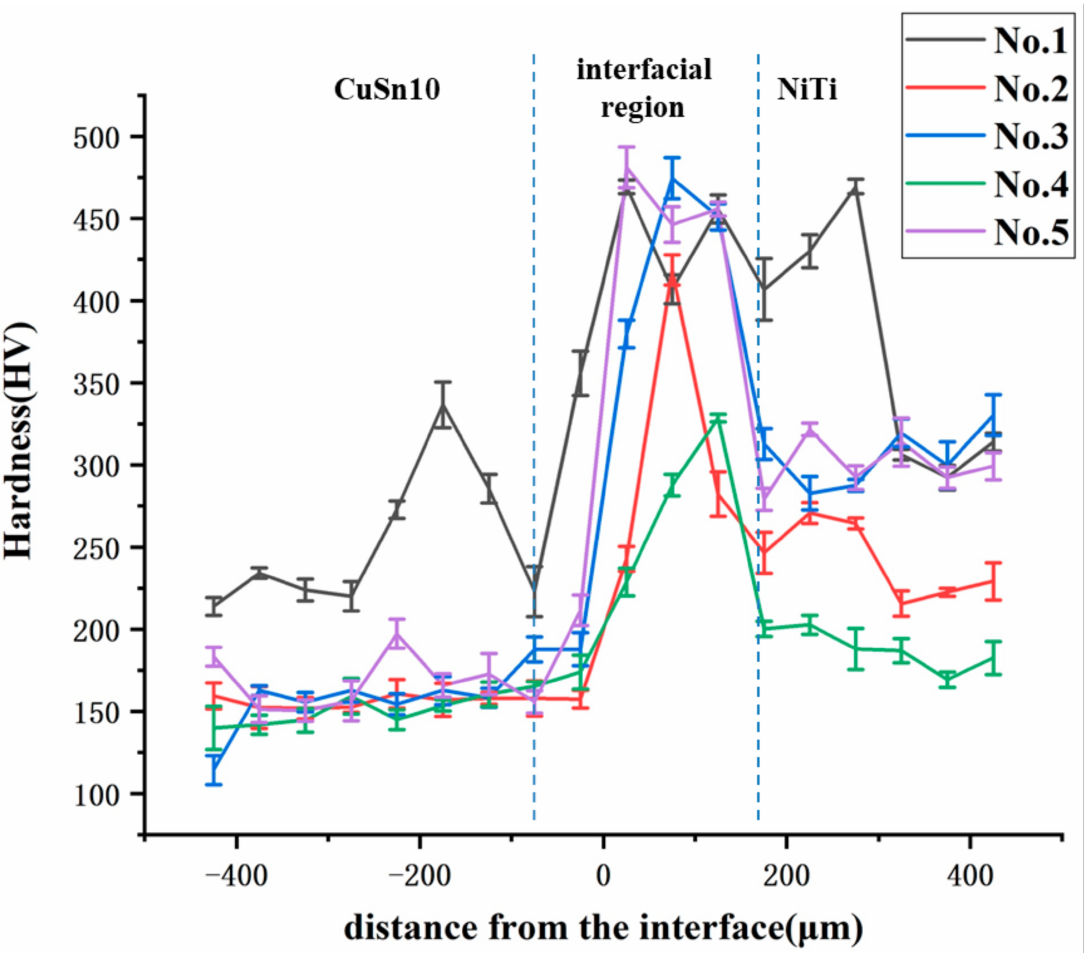
Figure 7. Microhardness change at the